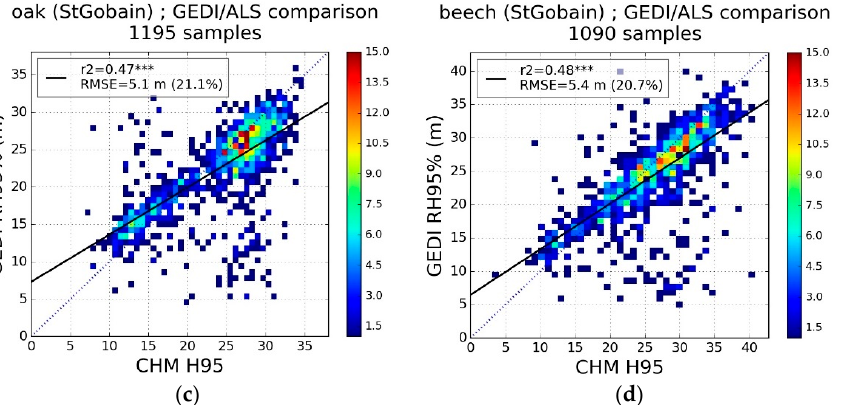
Figure 6. Comparison of the height 95th percentile (H95, proxy for dominant height) from ALS data and GEDI relative height metric at 95% (RH95%). ( a ) Orléans, oak; ( b ) Orléans, Scots pine; ( c ) StGobain, oak; ( d ) StGobain, beech. Statistical signicicance: *** p ≤ 0.001.